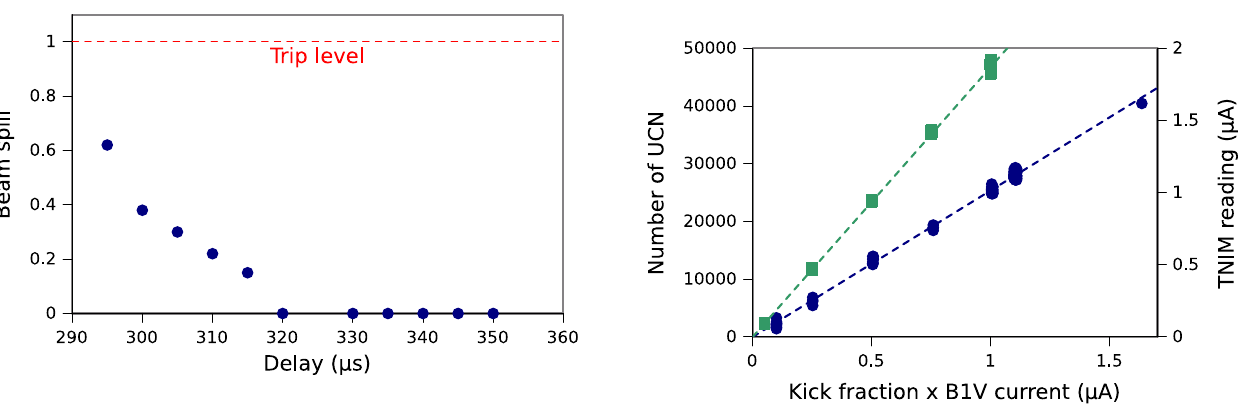
FIG. 20. Signal of beam spill monitor downstream of septum magnet, as a function of the kicker delay with respect to the cyclotron injection pulser. The beam spill signal is expressed as a fraction of the value at which the beam spill monitor will trip the cyclotron.